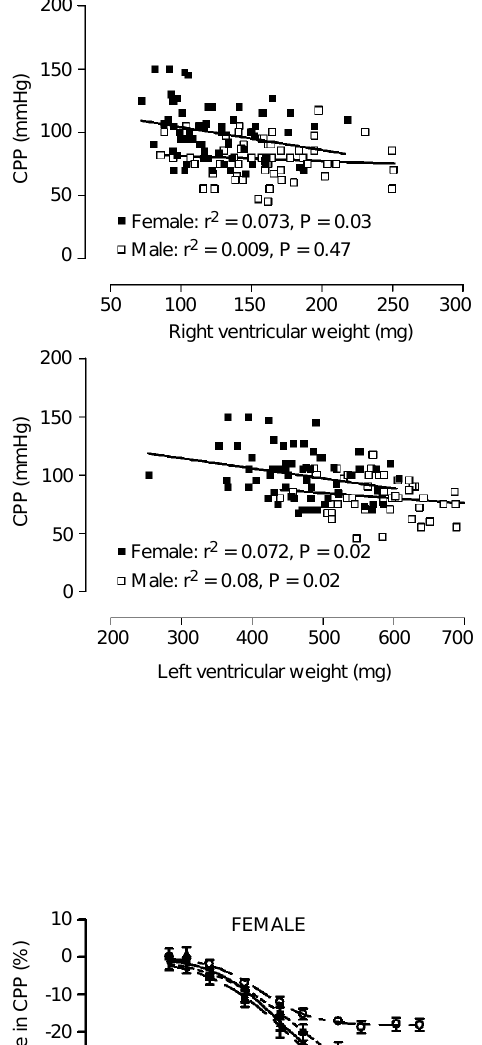
Figure 2. Dose-response curves for coronary vasodilation pro- duced by serotonin (5-HT). Each symbol and bar indicate the mean ± SEM. The top panel shows the percent decrease in coronary perfusion pressure (CPP) in female rats and the bot- tom panel shows CPP in male